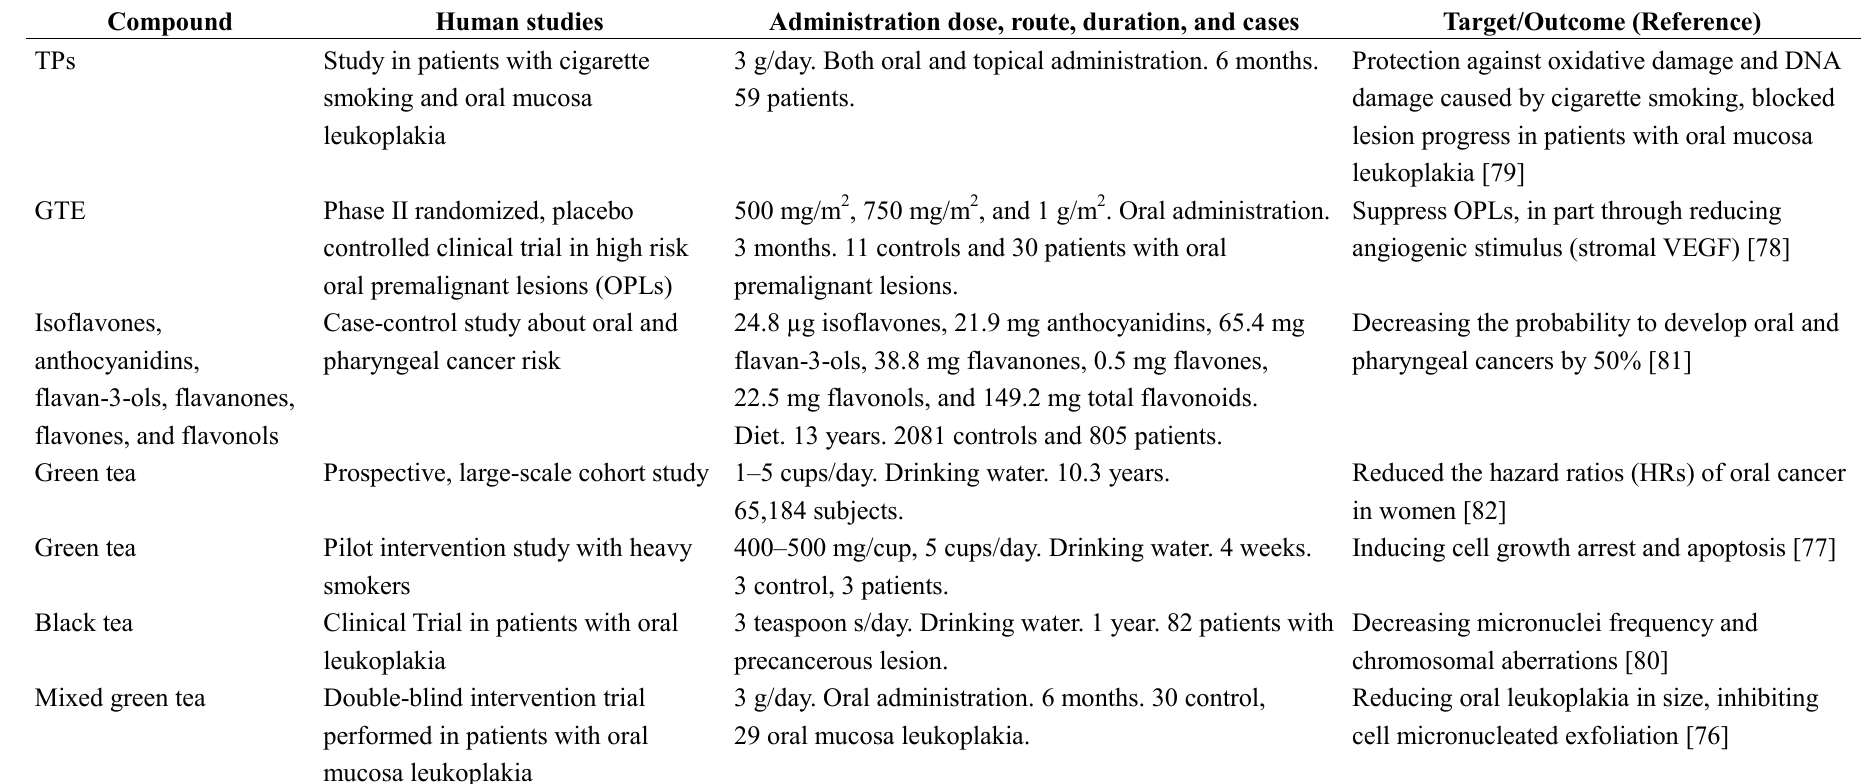
Table 3. Summary of epidemiologic and clinical studies of dietary polyphenols against oral